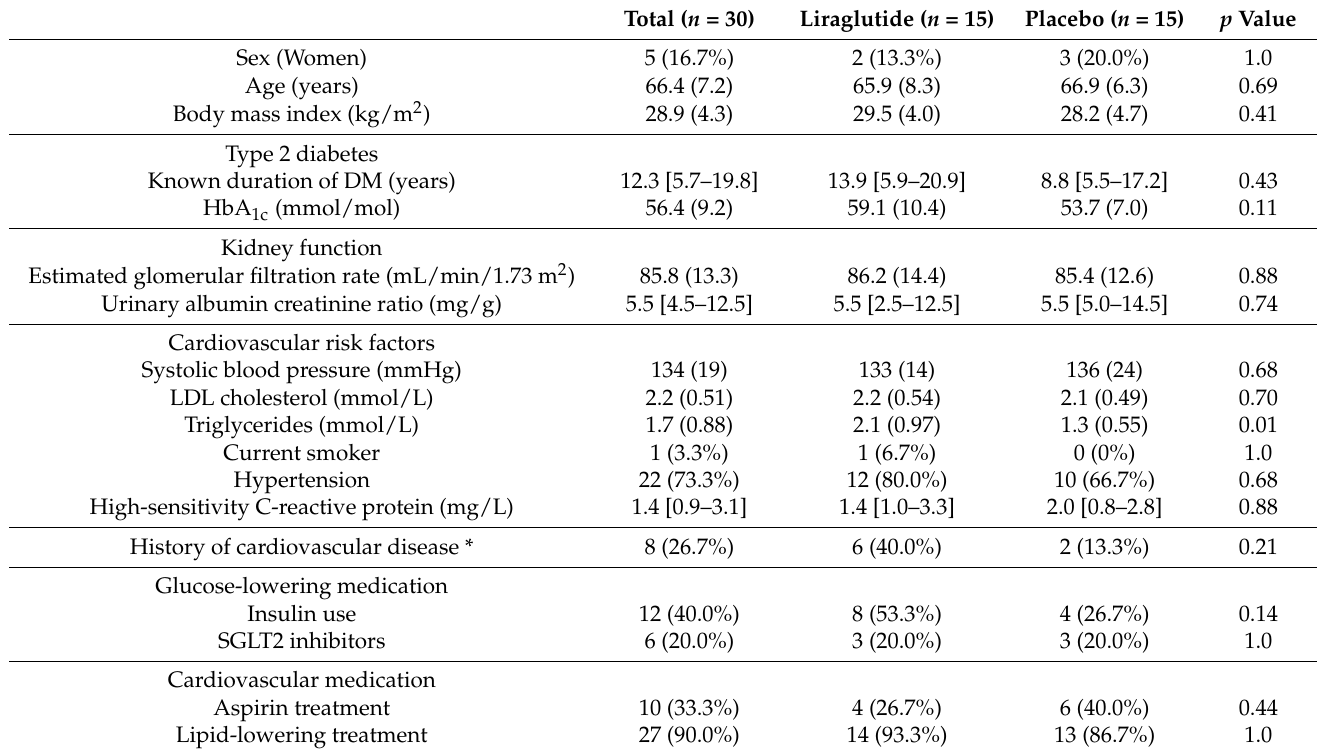
Table 1. Characteristics of the participants at